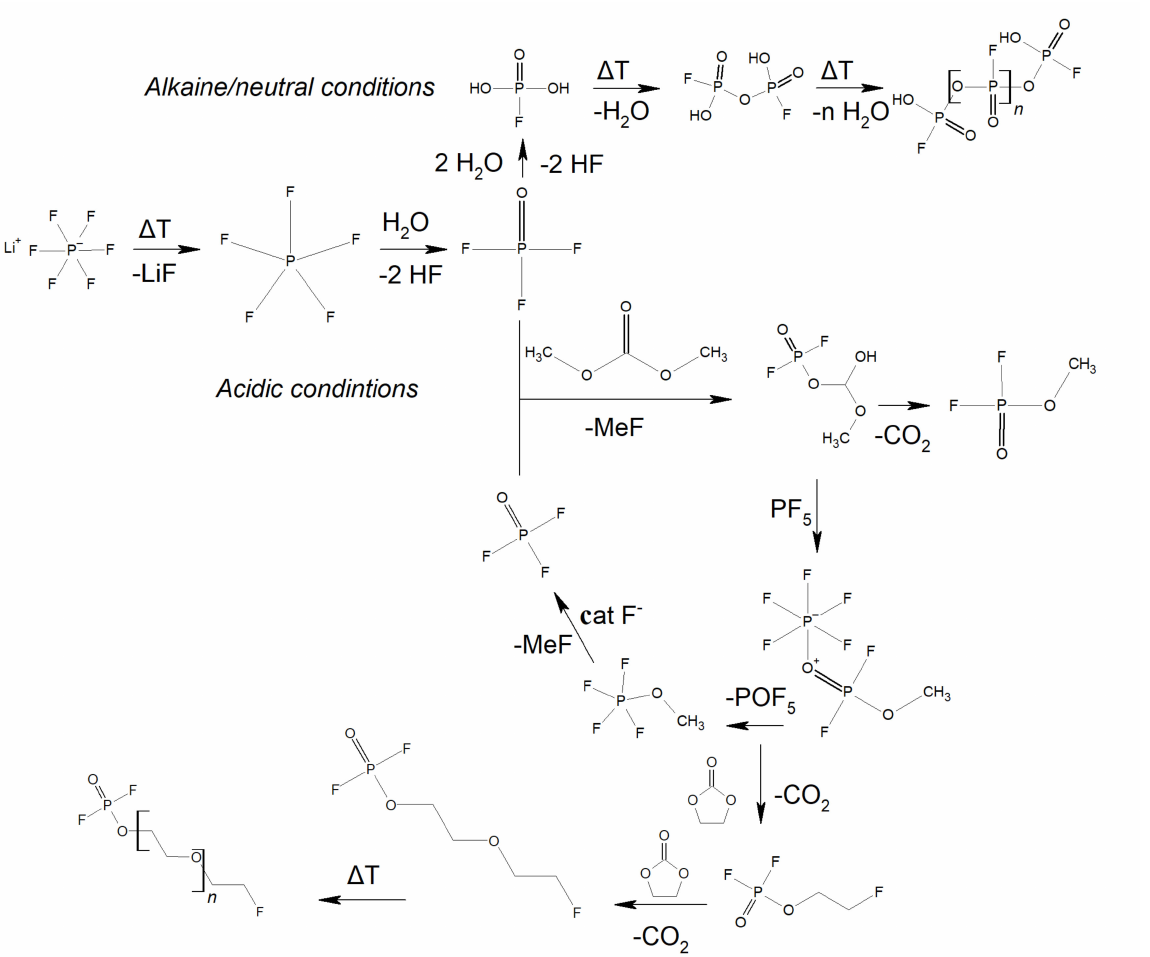
Figure 3. The mechanism of degradation of 1 M LIPF 6 in